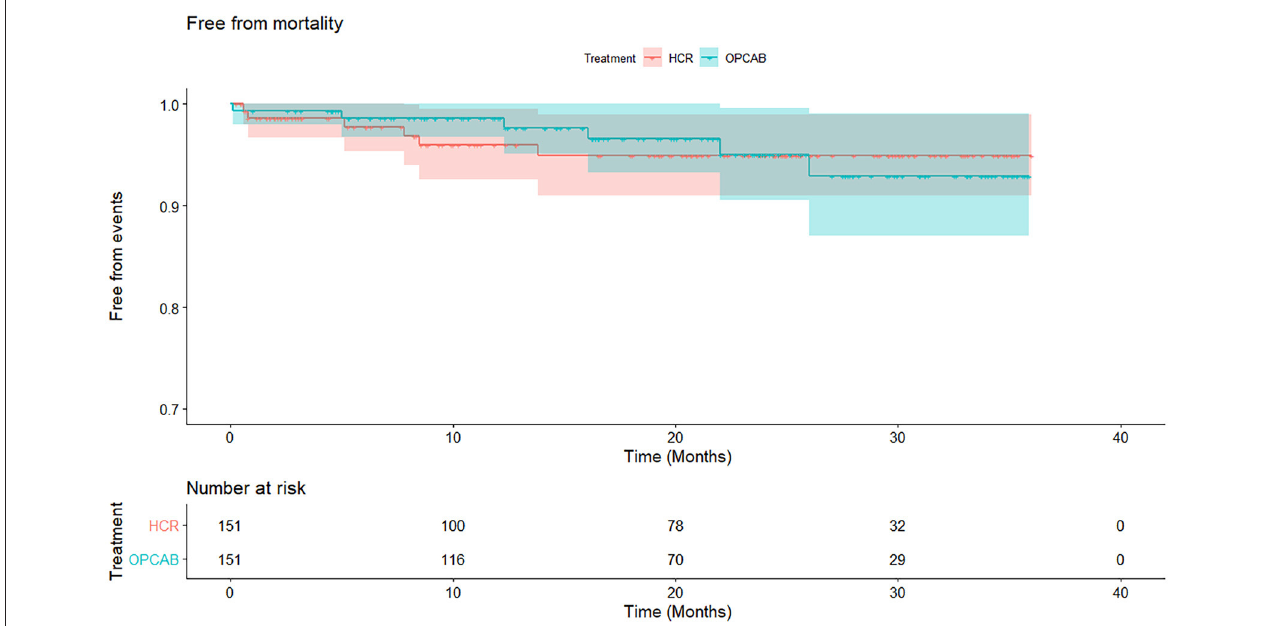
FIGURE 2 | Cumulative survival rate in hybrid coronary revascularization (HCR) and off-pump coronary artery bypass (OPCAB) group. Kaplan–Meier curve estimates similar cumulated survival rate in HCR and OPCAB groups (94.9 vs. 92.9%, p = 0.91) during the follow-up. HCR, hybrid coronary revascularization; OPCAB, off-pump coronary artery bypass graft.